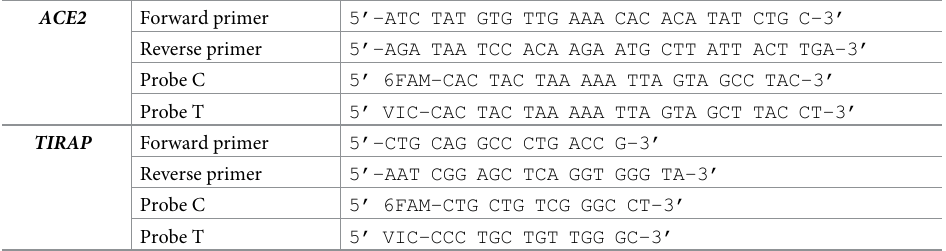
Table 1. ACE2 and TIRAP primers and probes